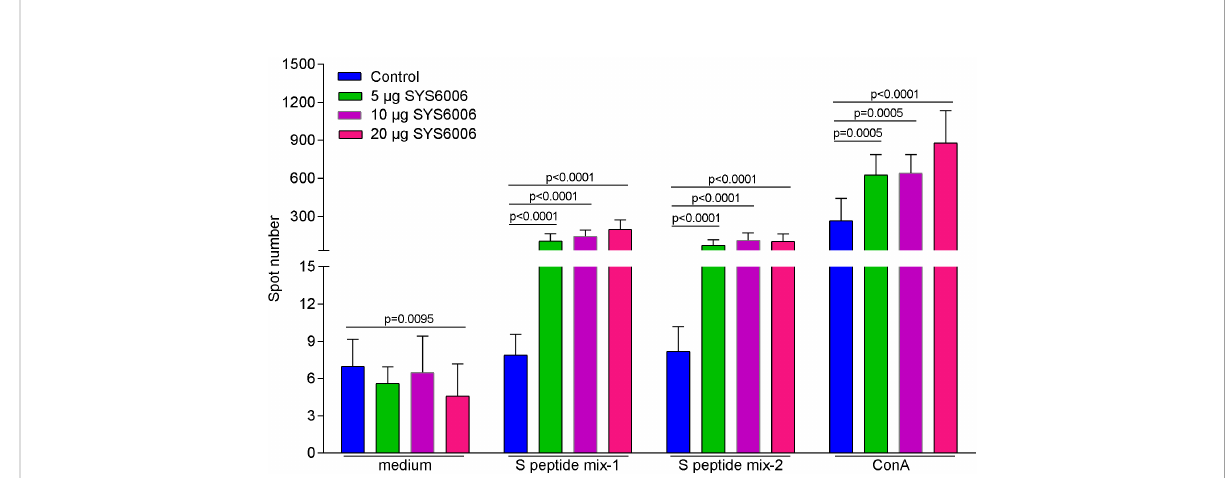
FIGURE 5 The T cell immunity against SARS-CoV-2 induced by SYS6006 in mice. 6-8-week-old female BALB/c mice were immunized intramuscularly with the indicated doses of SYS6006 and boosted with the same dose on day 21 post initial immunization. The splenocytes were collected 14 days after boost vaccination, stimulated with 2 peptide mixtures of S protein, and tested for T cell activity via mouse IFN- g ELISpot assay (n=10). Data are presented as mean ± SD. Concanavalin A (ConA) was positive control to stimulate T